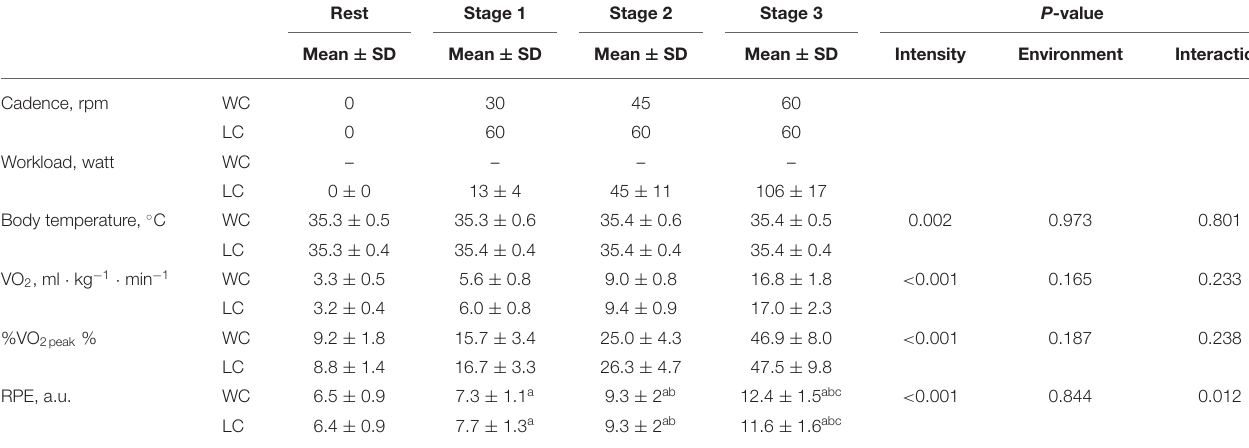
TABLE 1 | Change in the body temperature and exercise intensity.